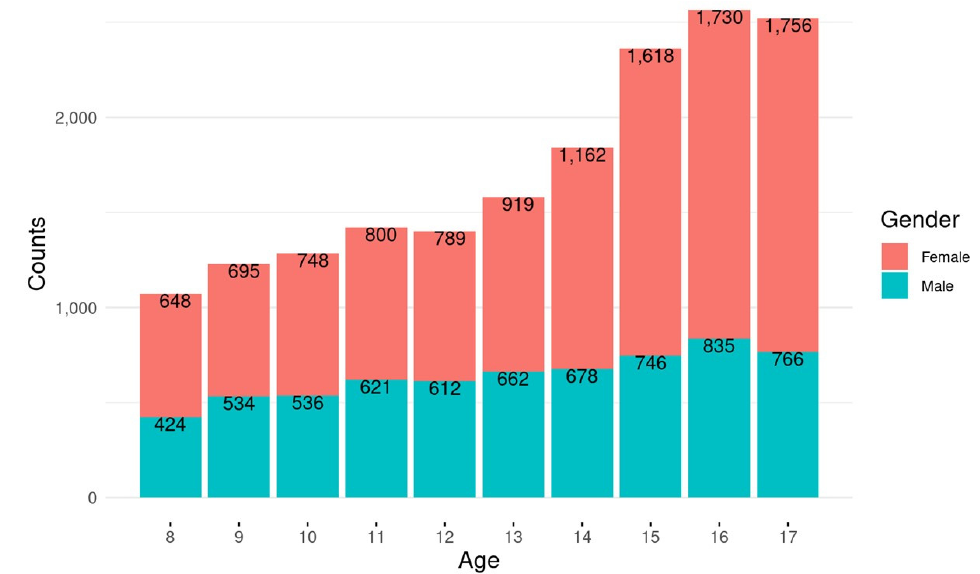
Figure 1. Case distribution by age and gender.